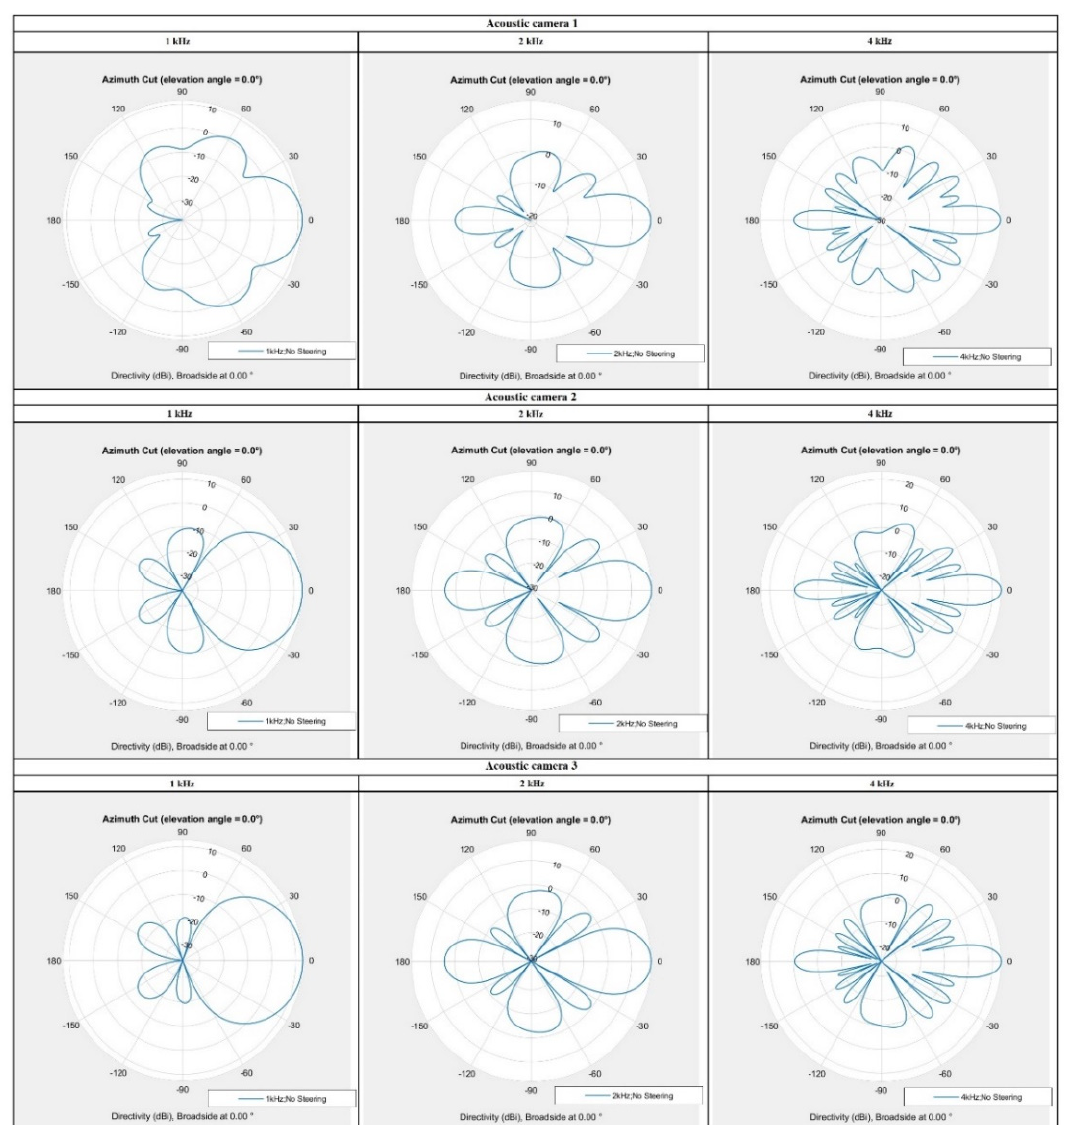
Figure 12. Directional characteristics of all acoustic camera prototypes (at frequencies 1, 2 and 4 kHz).